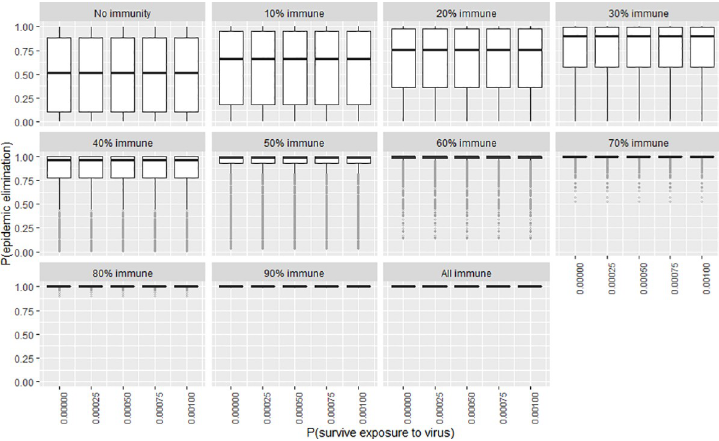
Fig 11. The certainty of the effect of exposure survival on P(elim.) at different herd immunities. The range of possible values when other parameters not shown in this plot are varied over their ranges. The boxplot shows the median, the interquartile range, minimums and maximums (1.5 times the 1 st and 3 rd quarter values) and outliers (grey